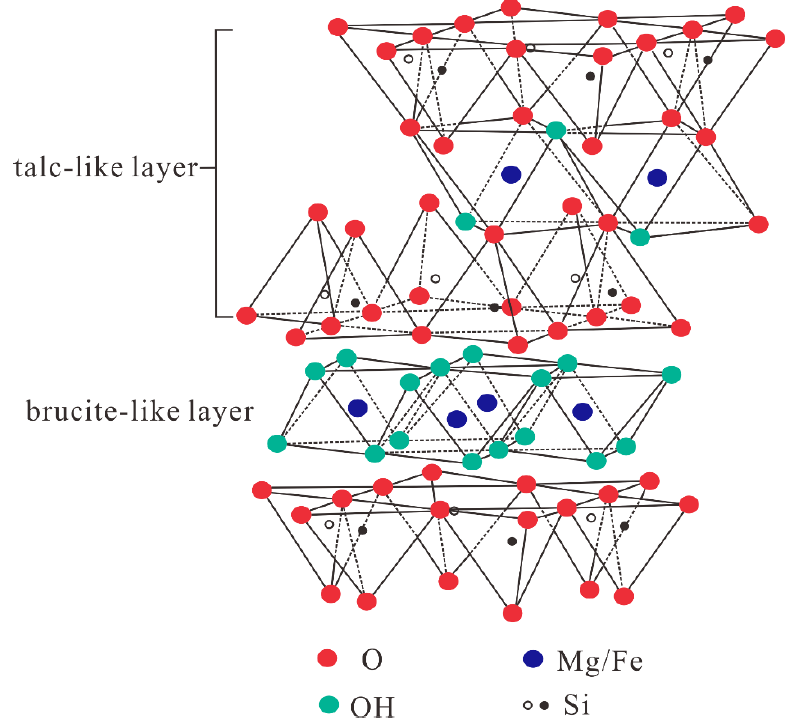
Figure 1. The structure of chlorite.